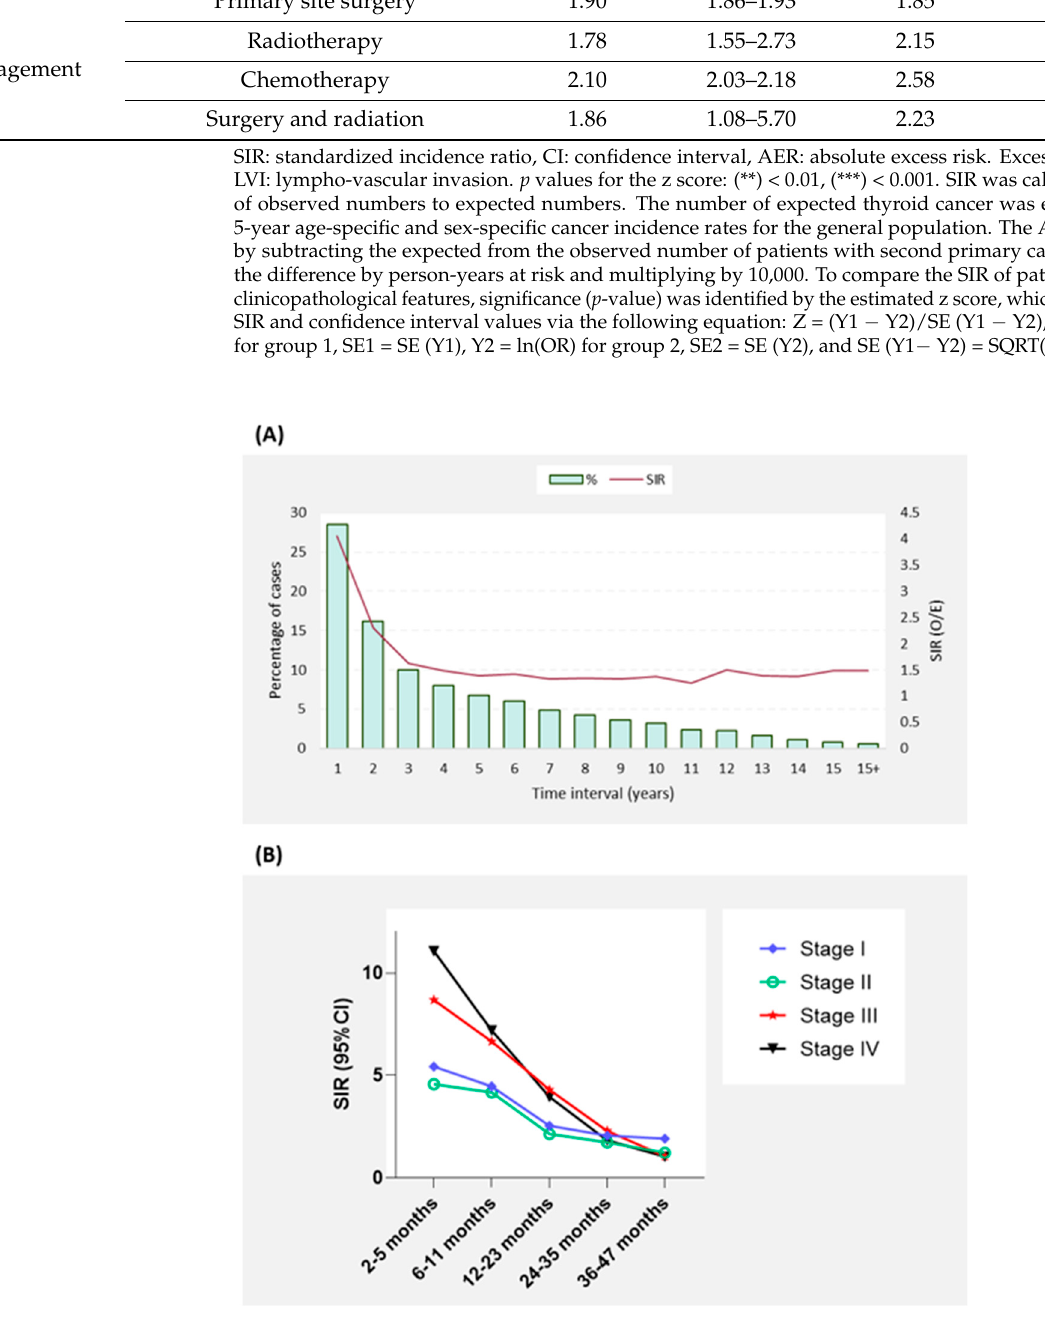
Figure 3. Overall incidence and risk of SPTC overtime after a primary cancer diagnosis. First-year does not include the first two months. SPTC: Second primary thyroid cancer. SIR: standardized incidence ratio (observed/expected). ( A ) Annual percentage of patients developing SPTC. ( B ) Latency course of SPTC development stratified by TC stage.